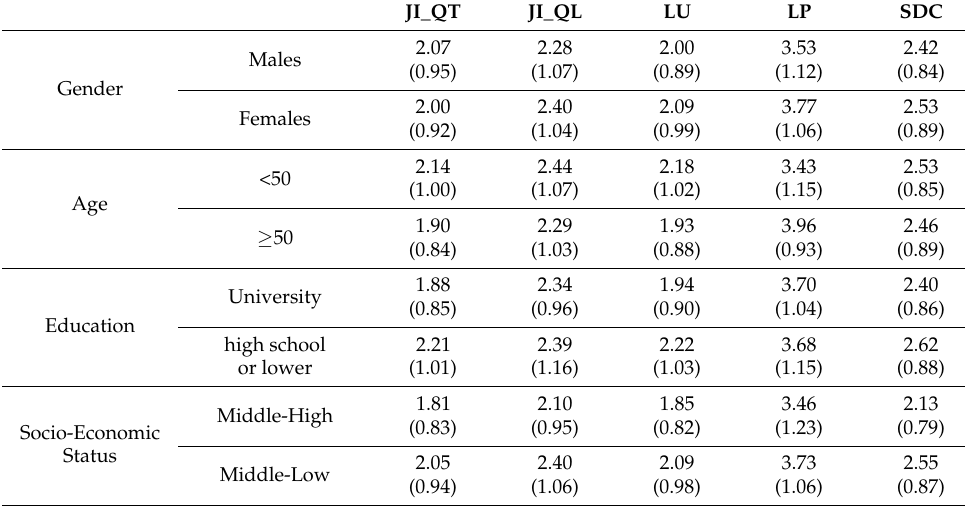
Table 6. Means and standard deviations (between brackets) of the studied variables in function of Gender, Age, Education and Socio-Economic